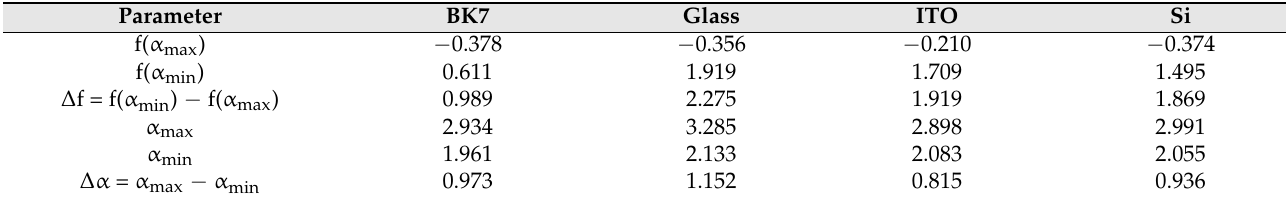
Figure 7. ( a ) Mass exponent τ (q), ( b ) generalized dimensions Dq and ( c ) multifractal spectra (f( α ) versus α ), as a function of the order of moments computed for BK7, glass, ITO, and Si film surface. For clarity, the BK7, ITO, and Si mass exponent curves are shifted by − 5, +5, and +10, respectively. Table 4. Measures of multifractal